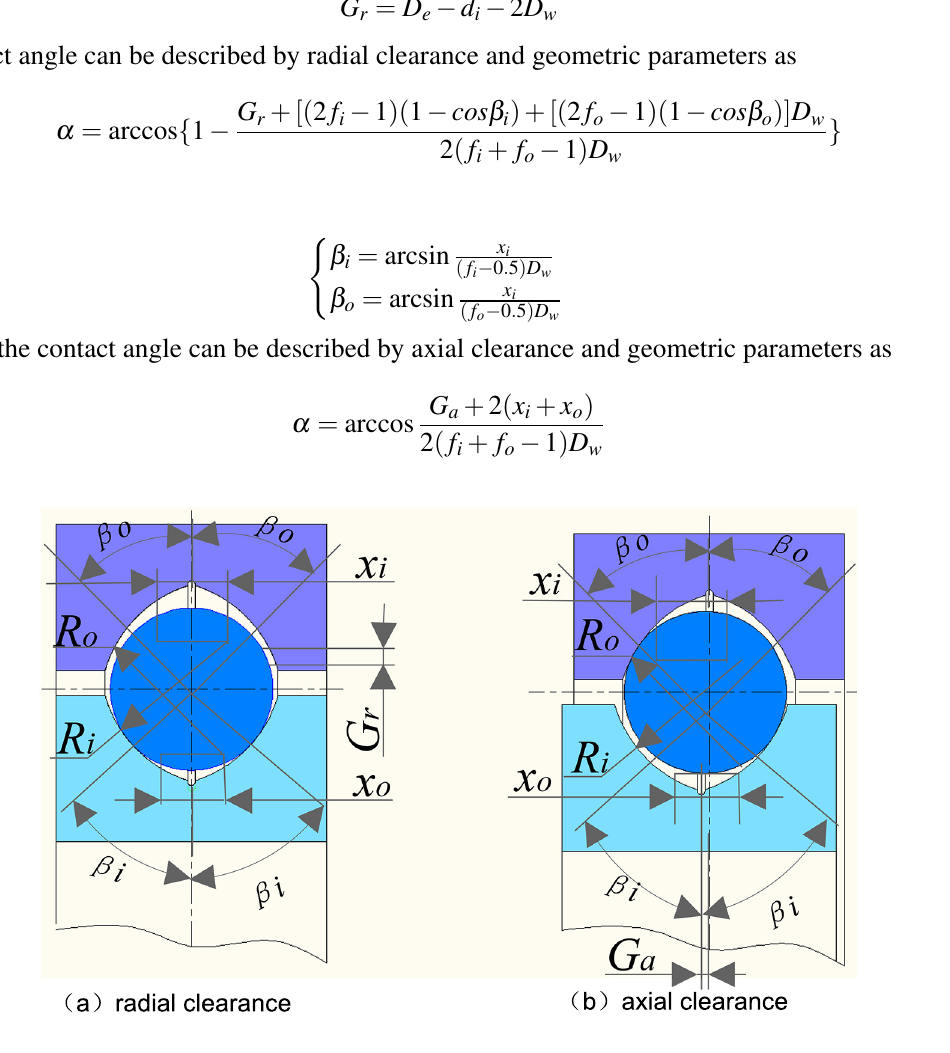
Fig. 2 contact angle variation owing to the